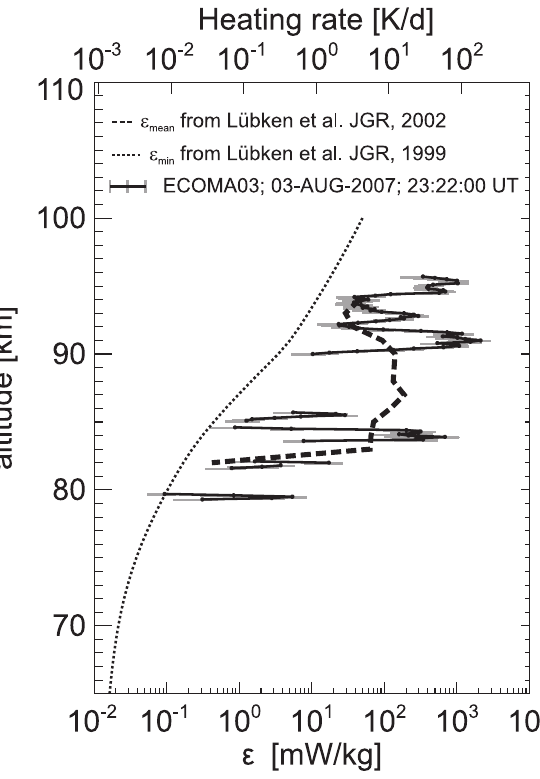
Fig. 2. In situ turbulence measurements during ECOMA flight. The dotted and dashed lines are the minimum and the mean ε -values, respectively, representing turbulence climatology for polar summer